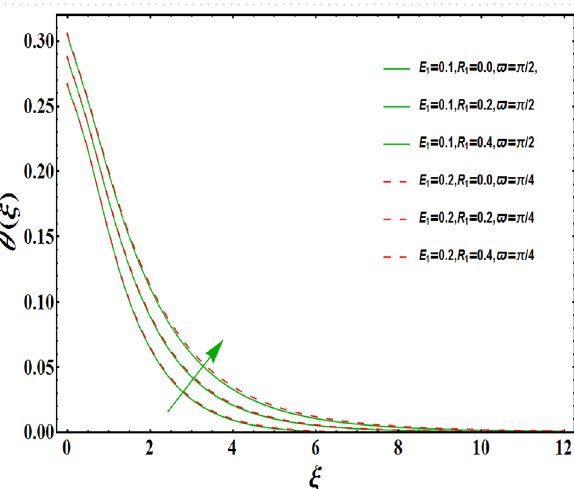
Figure 13. Variation of A < 0 on θ(ξ) for both with and without inclanation.